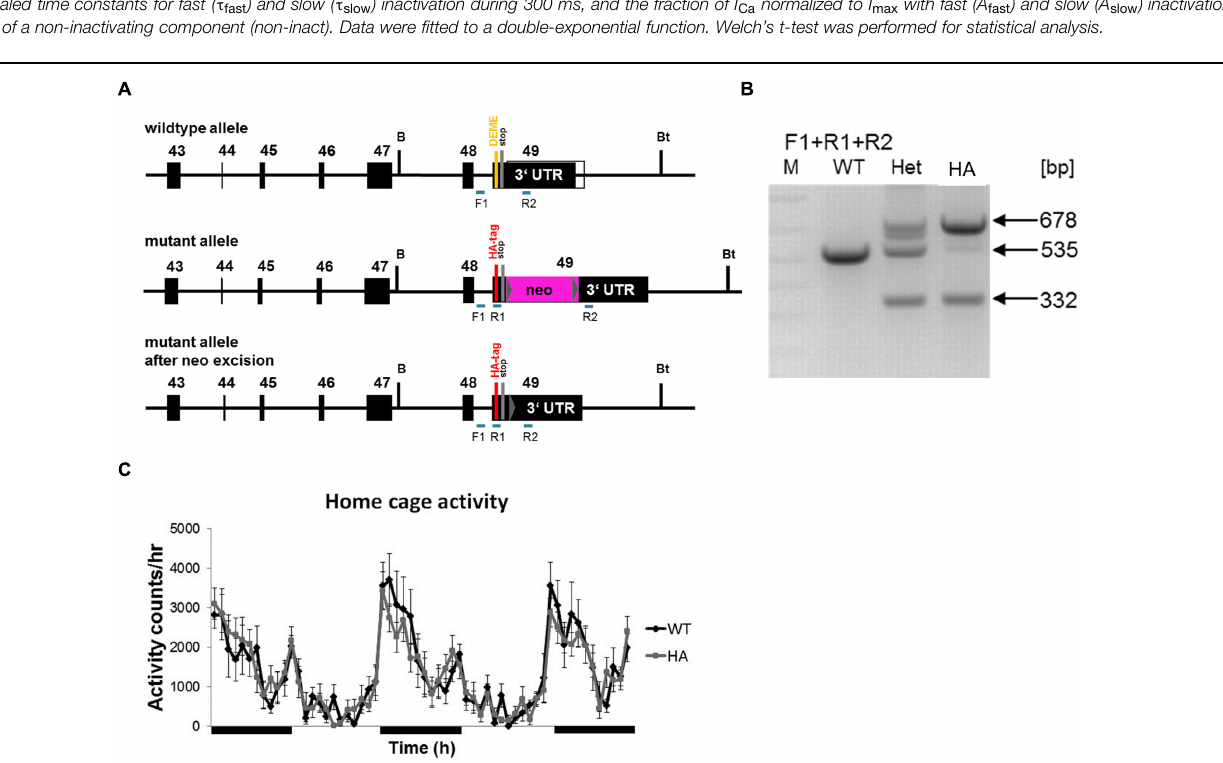
(B) Genotyping reactions yielding the expected fragment sizes are shown for WT, hetero- (Het) and homozygous (HA) mutant mice. (C) Hourly time course of home cage activity in HA ( n = 10, gray) and WT mice ( n = 11, black) recorded over three consecutive dark and two light cycles as described in Methods. Black bars indicate dark periods. Data are presented as Mean ±